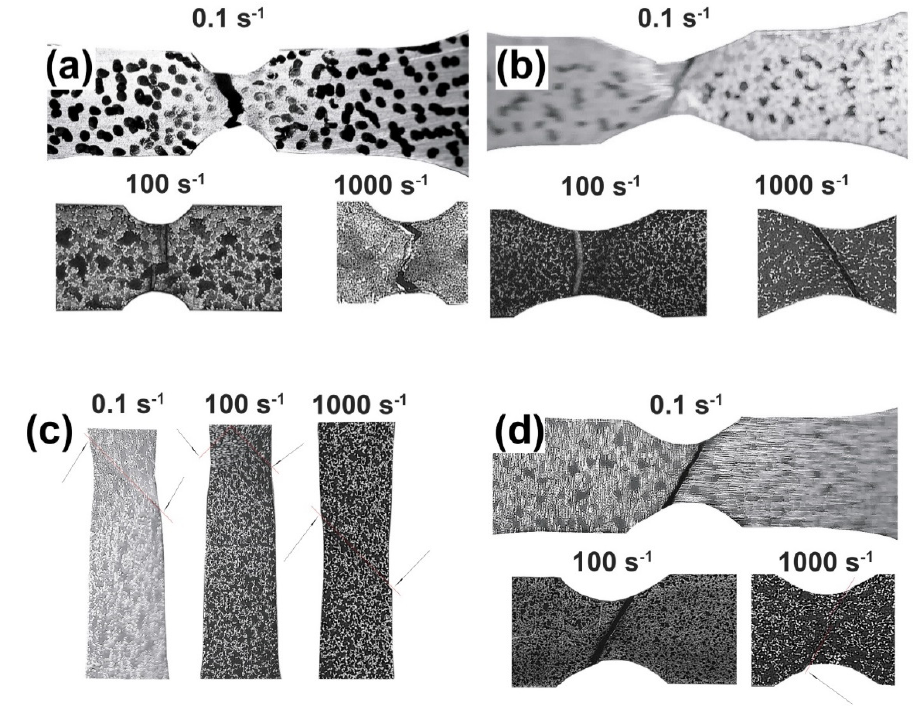
Figure 9. Frame of specimens before fracture; ( a ) notch radius R = 2.5 mm, ( b ) R = 10 mm, ( c ) specimens without notches, and ( d ) R = 5 mm.